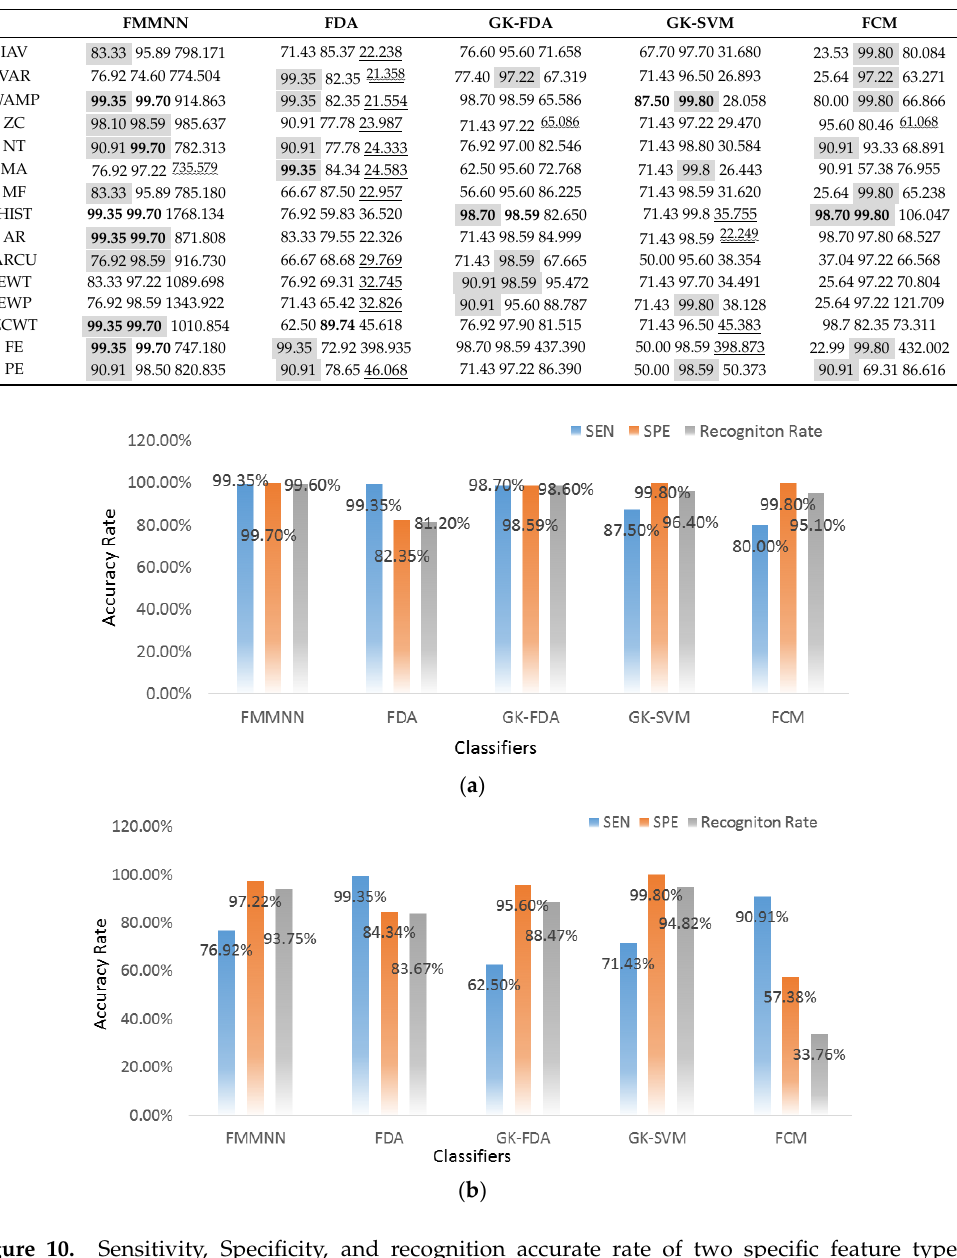
( b ) Figure 10. Sensitivity, Specificity, and recognition accurate rate of two specific feature types. ( a ) Figure 10. Sensitivity, Specificity, and recognition accurate rate of two specific feature types. ( a ) Figure 10. Sensitivity, Specificity, and recognition accurate rate of two specific feature types. ( a ) Table 4. Sensitivity, Specificity and Calculation times (%, % and ms). The bold numbers indicate Figure 10. Sensitivity, Specificity, and recognition accurate rate of two specific feature types. ( a ) Sensitivity, Specificity, and whole recognition rate of WAMP. ( b ) Sensitivity, Specificity, and Figure 10. Sensitivity, Specificity, and recognition accurate rate of two specific feature types. ( a ) Sensitivity, Specificity, and whole recognition rate of WAMP. ( b ) Sensitivity, Specificity, and Sensitivity, Specificity, and whole recognition rate of WAMP. ( b ) Sensitivity, Specificity, and Sensitivity, Specificity, and whole recognition rate of WAMP. ( b ) Sensitivity, Specificity, and Recognition Rate of MA. the features with highest Sensitivity and Specificity rate for each classifier. The shaded indicate the Sensitivity, Specificity, and whole recognition rate of WAMP. ( b ) Sensitivity, Specificity, and Recognition Rate of MA. Recognition Rate of MA. Recognition Rate of MA. Recognition Rate of MA. classifiers with the highest Sensitivity and Specificity rate for each feature. The zigzag underlines Table 4. Sensitivity, Specificity and Calculation times (%, % and ms). The bold numbers indicate the Table 4. Sensitivity, Specificity and Calculation times (%, % and ms). The bold numbers indicate the Table 4. Sensitivity, Specificity and Calculation times (%, % and ms). The bold numbers indicate the Table 4. Sensitivity, Specificity and Calculation times (%, % and ms). The bold numbers indicate the indicate the features with shortest calculation time for each classifier. The straight underlines indicate features with highest Sensitivity and Specificity rate for each classifier. The shaded indicate the Table 4. Sensitivity, Specificity and Calculation times (%, % and ms). The bold numbers indicate the features with highest Sensitivity and Specificity rate for each classifier. The shaded indicate the features with highest Sensitivity and Specificity rate for each classifier. The shaded indicate the features with highest Sensitivity and Specificity rate for each classifier. The shaded indicate the classifiers with the highest Sensitivity and Specificity rate for each feature. The zigzag underlines features with highest Sensitivity and Specificity rate for each classifier. The shaded indicate the the classifiers with shortest calculation time for each feature. classifiers with the highest Sensitivity and Specificity rate for each feature. The zigzag underlines classifiers with the highest Sensitivity and Specificity rate for each feature. The zigzag underlines classifiers with the highest Sensitivity and Specificity rate for each feature. The zigzag underlines indicate the features with shortest calculation time for each classifier. The straight underlines classifiers with the highest Sensitivity and Specificity rate for each feature. The zigzag underlines indicate the features with shortest calculation time for each classifier. The straight underlines indicate the features with shortest calculation time for each classifier. The straight underlines indicate the features with shortest calculation time for each classifier. The straight underlines indicate the classifiers with shortest calculation time for each feature. indicate the features with shortest calculation time for each classifier. The straight underlines indicate the classifiers with shortest calculation time for each feature. indicate the classifiers with shortest calculation time for each feature. indicate the classifiers with shortest calculation time for each feature. indicate the classifiers with shortest calculation time for each feature.